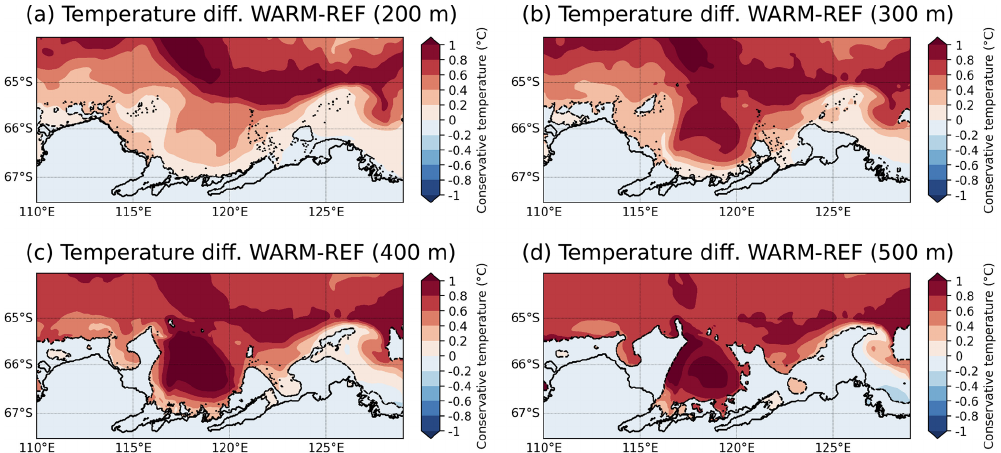
Figure 9. Annual mean ocean temperature differences between the WARM and REF simulations over the continental shelf at 200, 300, 400 and 500m depths, all averaged over the 20 years of simulation. The dashed line depicts the contours of the 200, 300, 400 and 500m depth topography for panels (a) , (b) , (c) and (d) ,